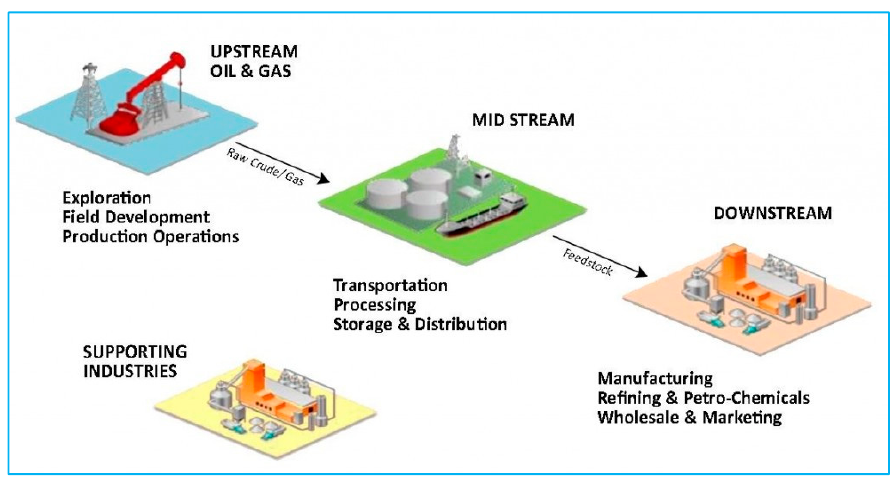
Figure 1. Global oil/gas sector value chain. Source: [5].